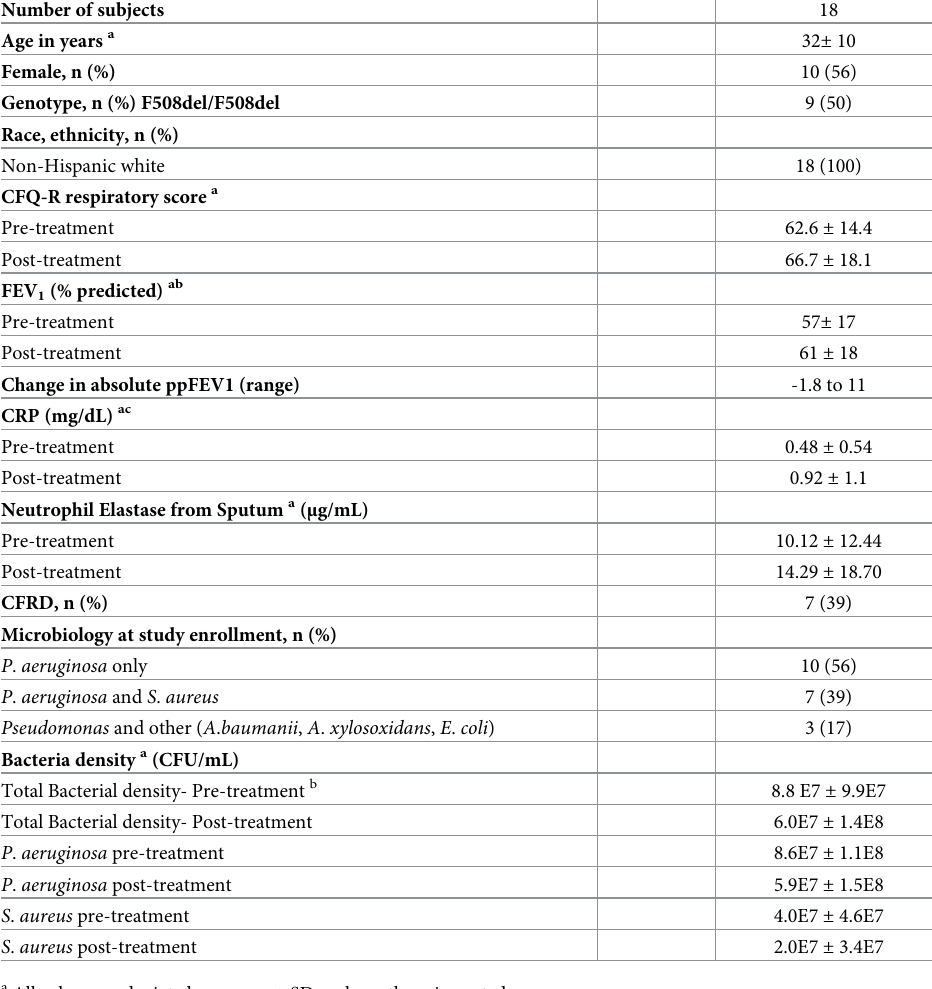
Table 1. Characteristics of study